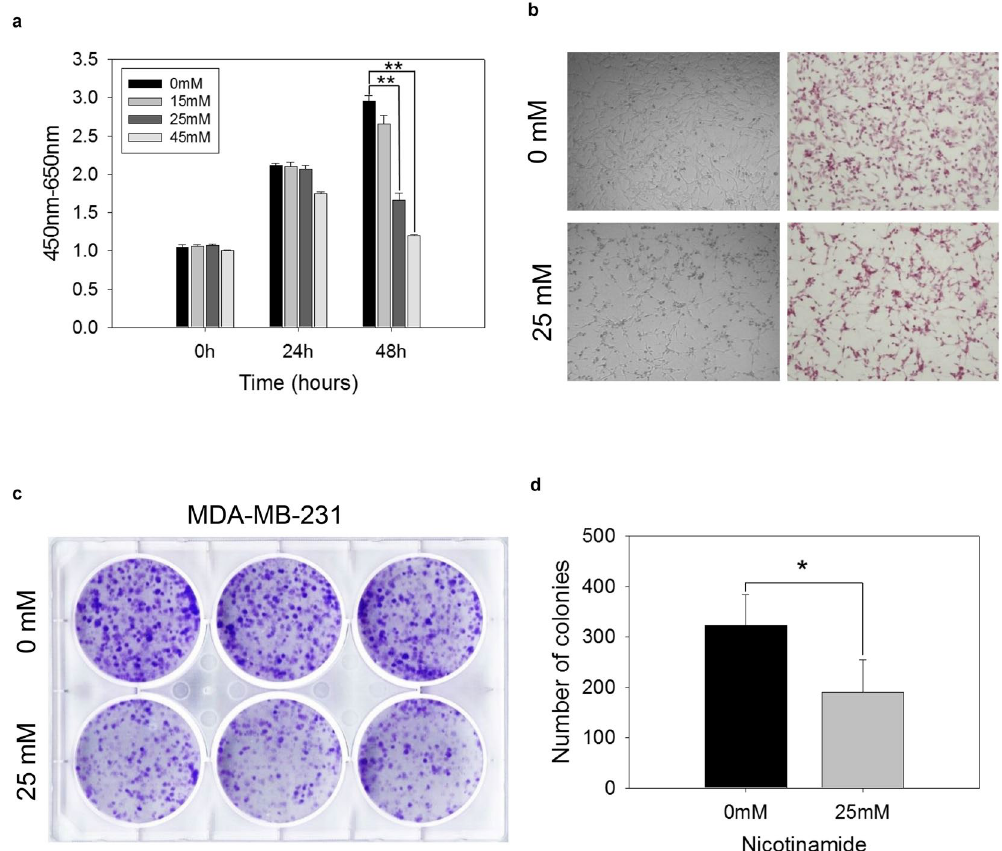
Figure 1. Effects of nicotinamide on breast cancer cell lines. ( a ) MDA-MB-231 cells were treated with 15, 25 and 45 mM nicotinamide. Dose-dependent cytotoxic effects were assessed every 24 and 48 h using a WST-1 assay. The data represent the mean ± SD ( ** P < 0.01). The cell morphology of MDA-MB-231 cells treated with 25 mM nicotinamide for 48 h via ( b ) light microscopy (left, original magnification x 100) and H&E staining (right, original magnification x 100). ( c ) Colony formation assays of MDA-MB-231 cells treated with nicotinamide 25 mM for 48 h. (d) The bar graph indicates colony numbers revealed by the colony formation assay. The data represent the mean ± SD ( * P <